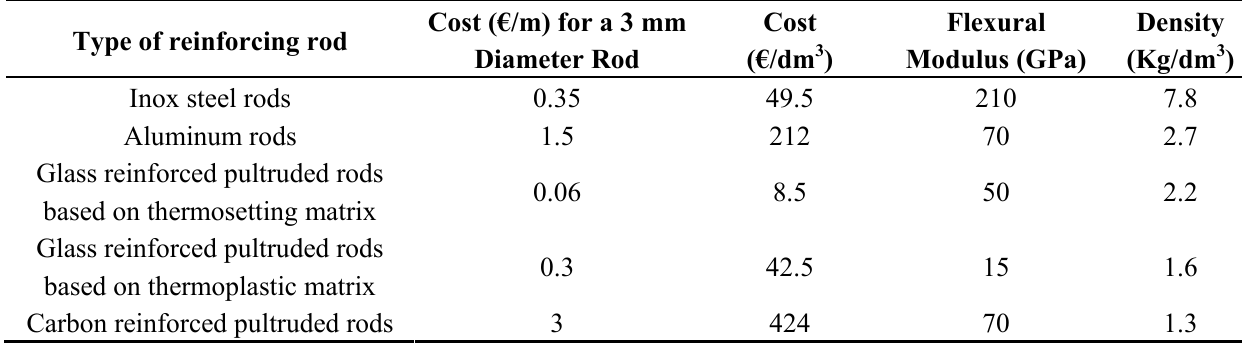
Table 1. Physical properties and estimated costs of reinforcing